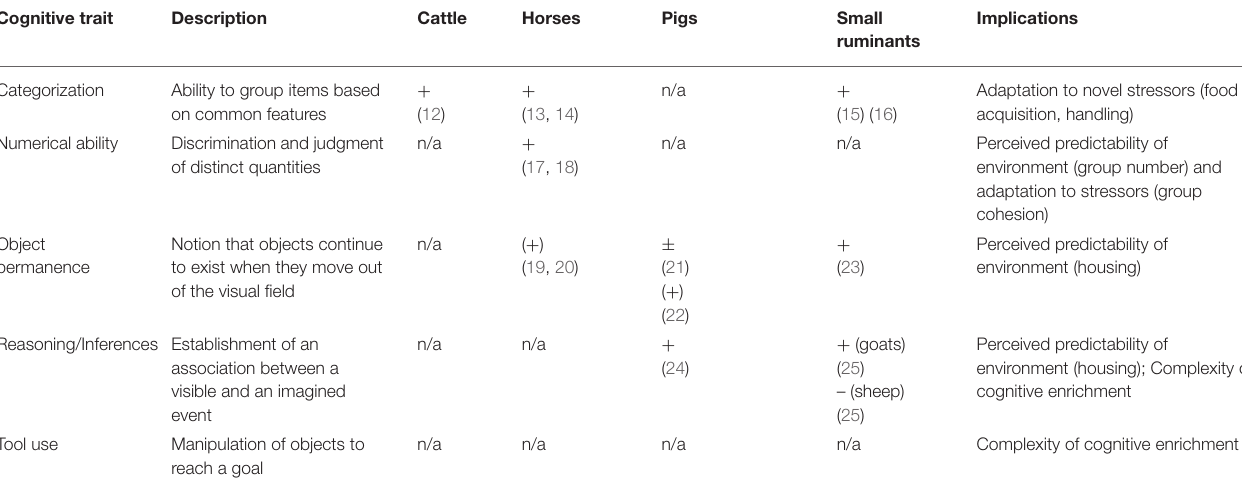
TABLE 1 | Overview on various physico-cognitive capacities, their description, evidence in different farm animals, and their implications. Cognitive trait